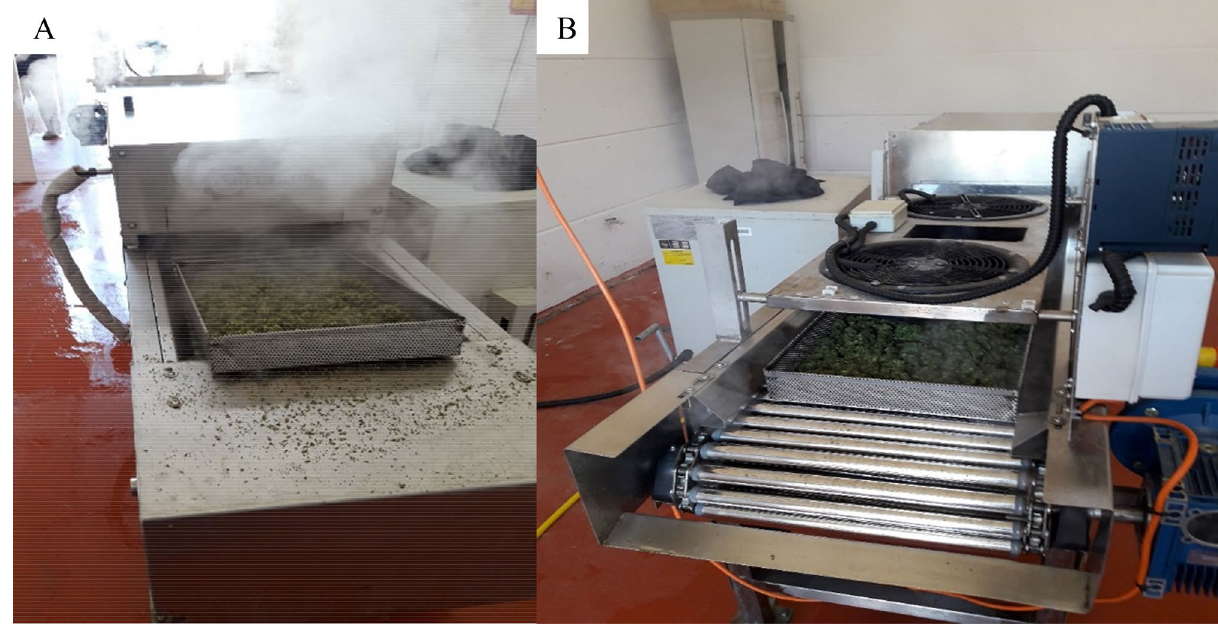
Figure 3. Steam sterilization prototype equipment used in this research, as shown from both ends. During the process, a stainless steel tray filled with MC inflorescences enters into the steam tunnel ( A ), exits the tunnel and is dried by the two top fans ( B